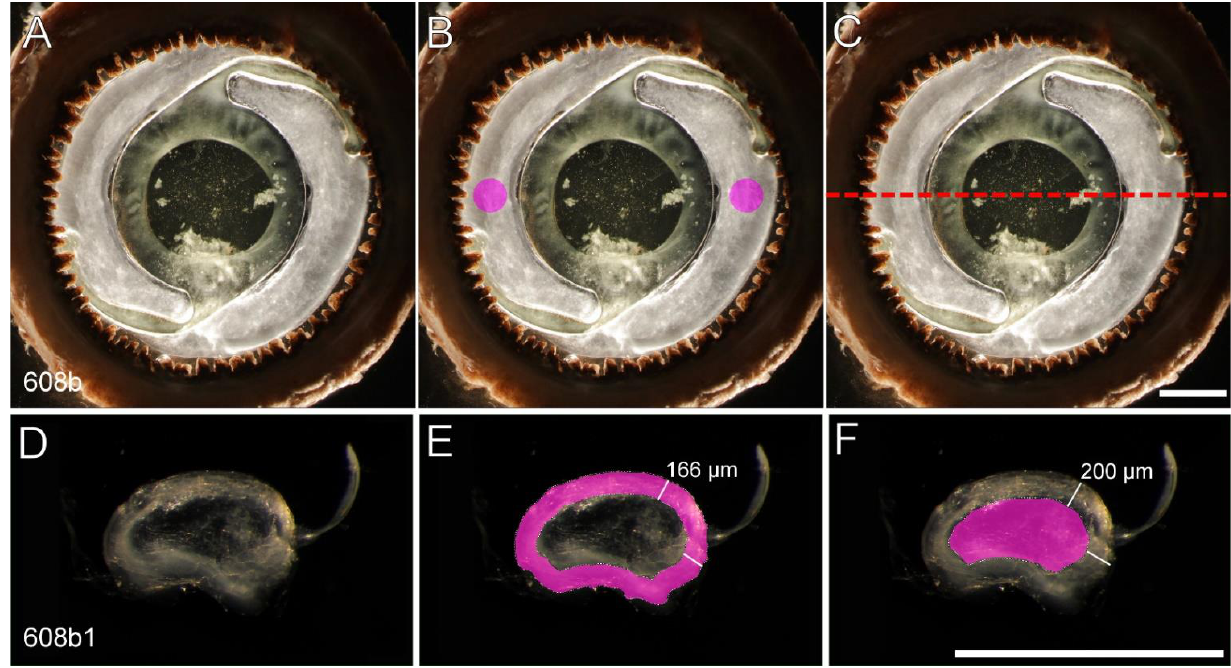
Figure 6. Frontal ( A , B and C ) and cross section ( D , E and F ) darkfield images of a sample (608b). ( B ) highlights (magenta) the 1 mm diameter areas analyzed for frontal transparency. ( C ) The red dashed line indicates where the cross-section was made. ( E , F ) highlight the two distinct areas analyzed for cross section transparency, ( E ) the periphery and ( F ) the center. Scale bars = 2 mm .